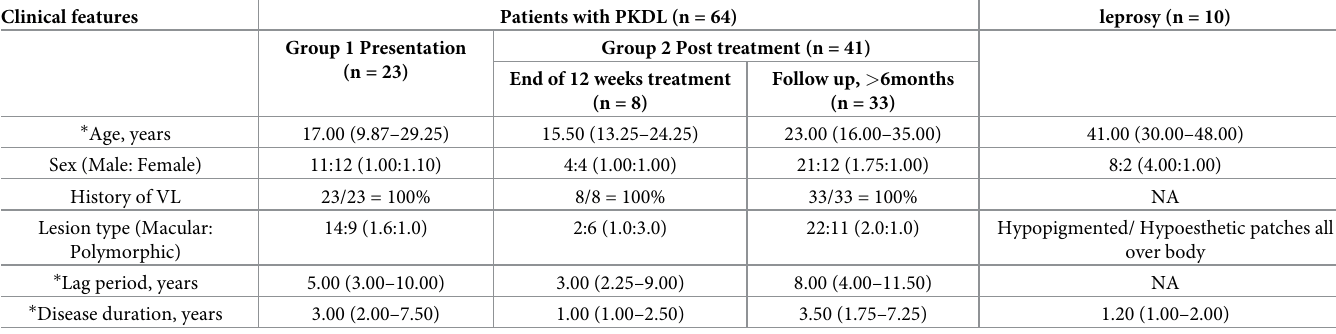
Table 2. Study population to assess performance of qPCR vs. RPA in PKDL. Clinical